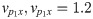
Suppression of parkinsonian beta activity for a 150 Hz external stimulus applied at t = 30 s with νζx = −1.2 mVs and vp1x,vp1x=1.2 mVs.(a) Time series of STN firing rate ϕζ with DBS stimulus applied at t = 30 s. (b) Power spectrum of STN firing rate ϕζ before DBS application using the time window t = 10–30 s (solid), and during DBS application using a time window t = 30–50 s (dashed).